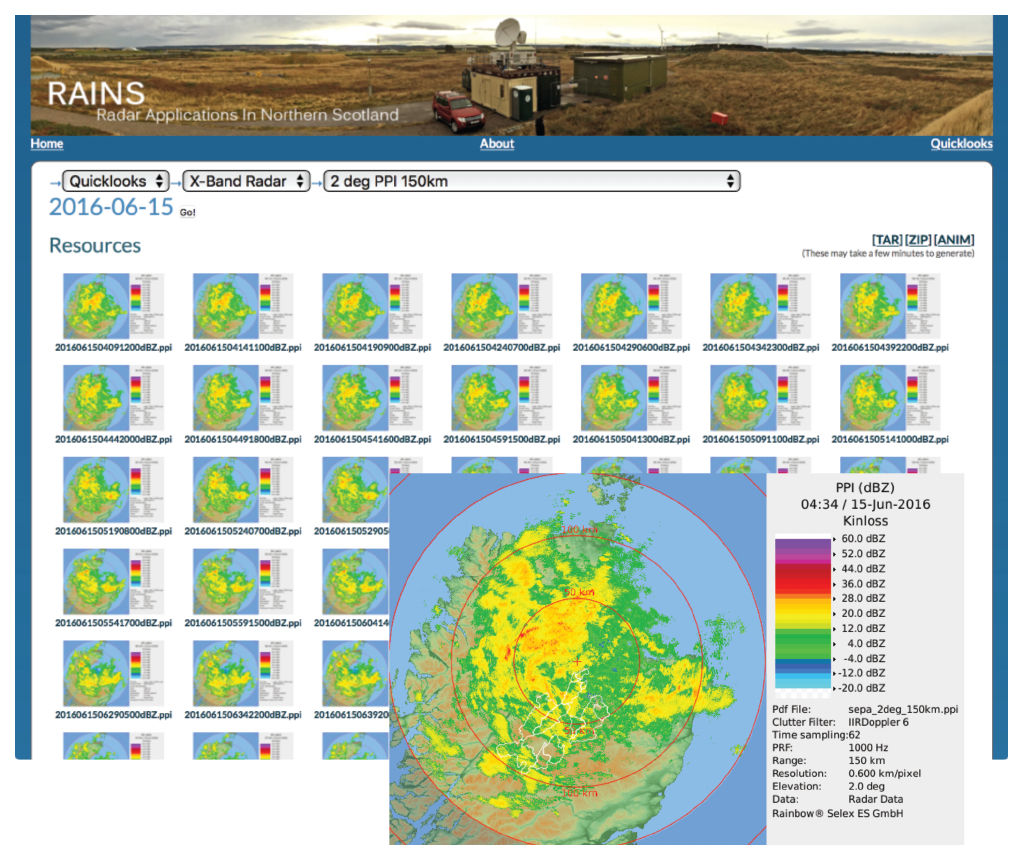
Figure 2. Example of the data catalogue used to monitor the NXPol observations in near-real time during the RAINS project described in Sect. 3.3. The background shows a collection of a set of images from a single day, while the foreground highlights an example of a near-real-time image produced by Rainbow ®